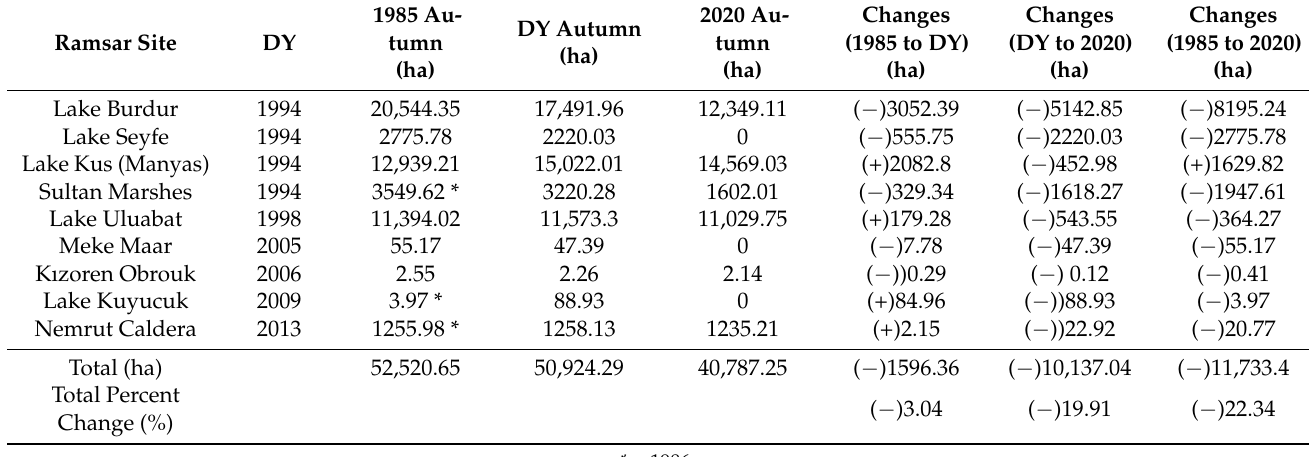
Table 8. The surface water areas of Ramsar Sites in autumn (1985, designation year (DY), and year 2020) and the changes.